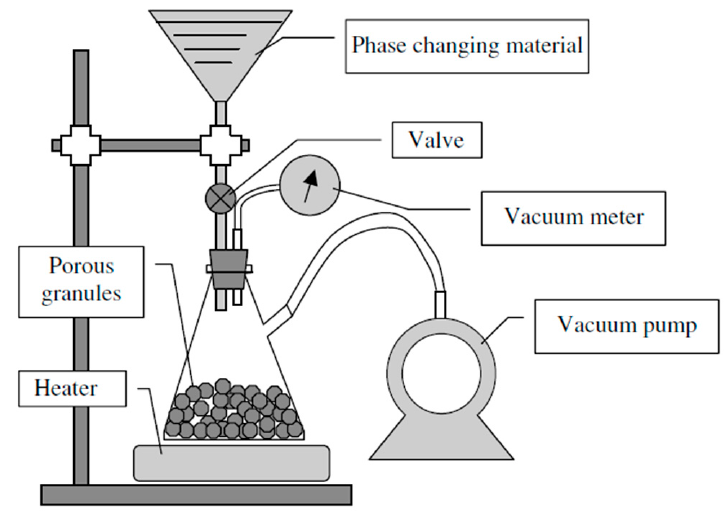
Figure 3. Vacuum impregnation of porous nanoparticles. (Reprinted with permission from ref. [48]. Copyright 2005 Solar Energy).